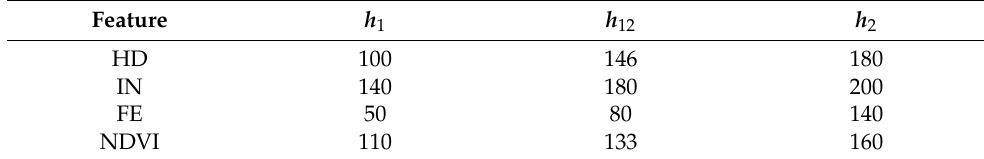
Table 2. BPA function parameters.